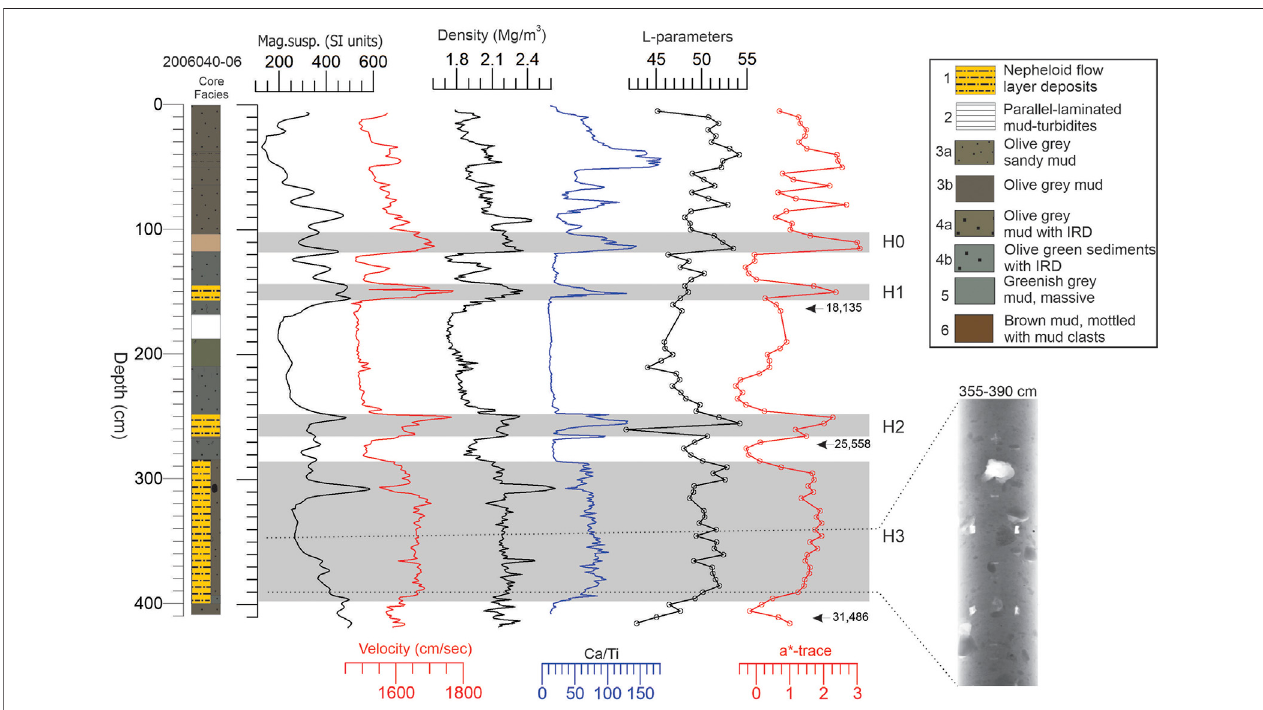
FIGURE 5 | Three sediment physical properties, that is, magnetic susceptibility, P-wave velocity, and density, Ca/Ti ratios, and sediment color L* and a*-traces betweenthecoretopand418 cmsubsurfacedepthofcoreHu2006040-06areplotted.Three 14 C-AMSdateswereusedtocon fi rmtheidenti fi cationofH1,H2,andH3 layers,whereastheX-radiographsandcorephotographswereusedtoguidetheidenti fi cationofsedimentarystructuresandfaciesshownincolumn(a).Arepresentative X-radiograph between 355 and 390 cm of H3 layer suggests a near absence of fi ne-grained plume laminae (suggesting that the Hudson Strait derived fi nes were depleted on the Hamilton